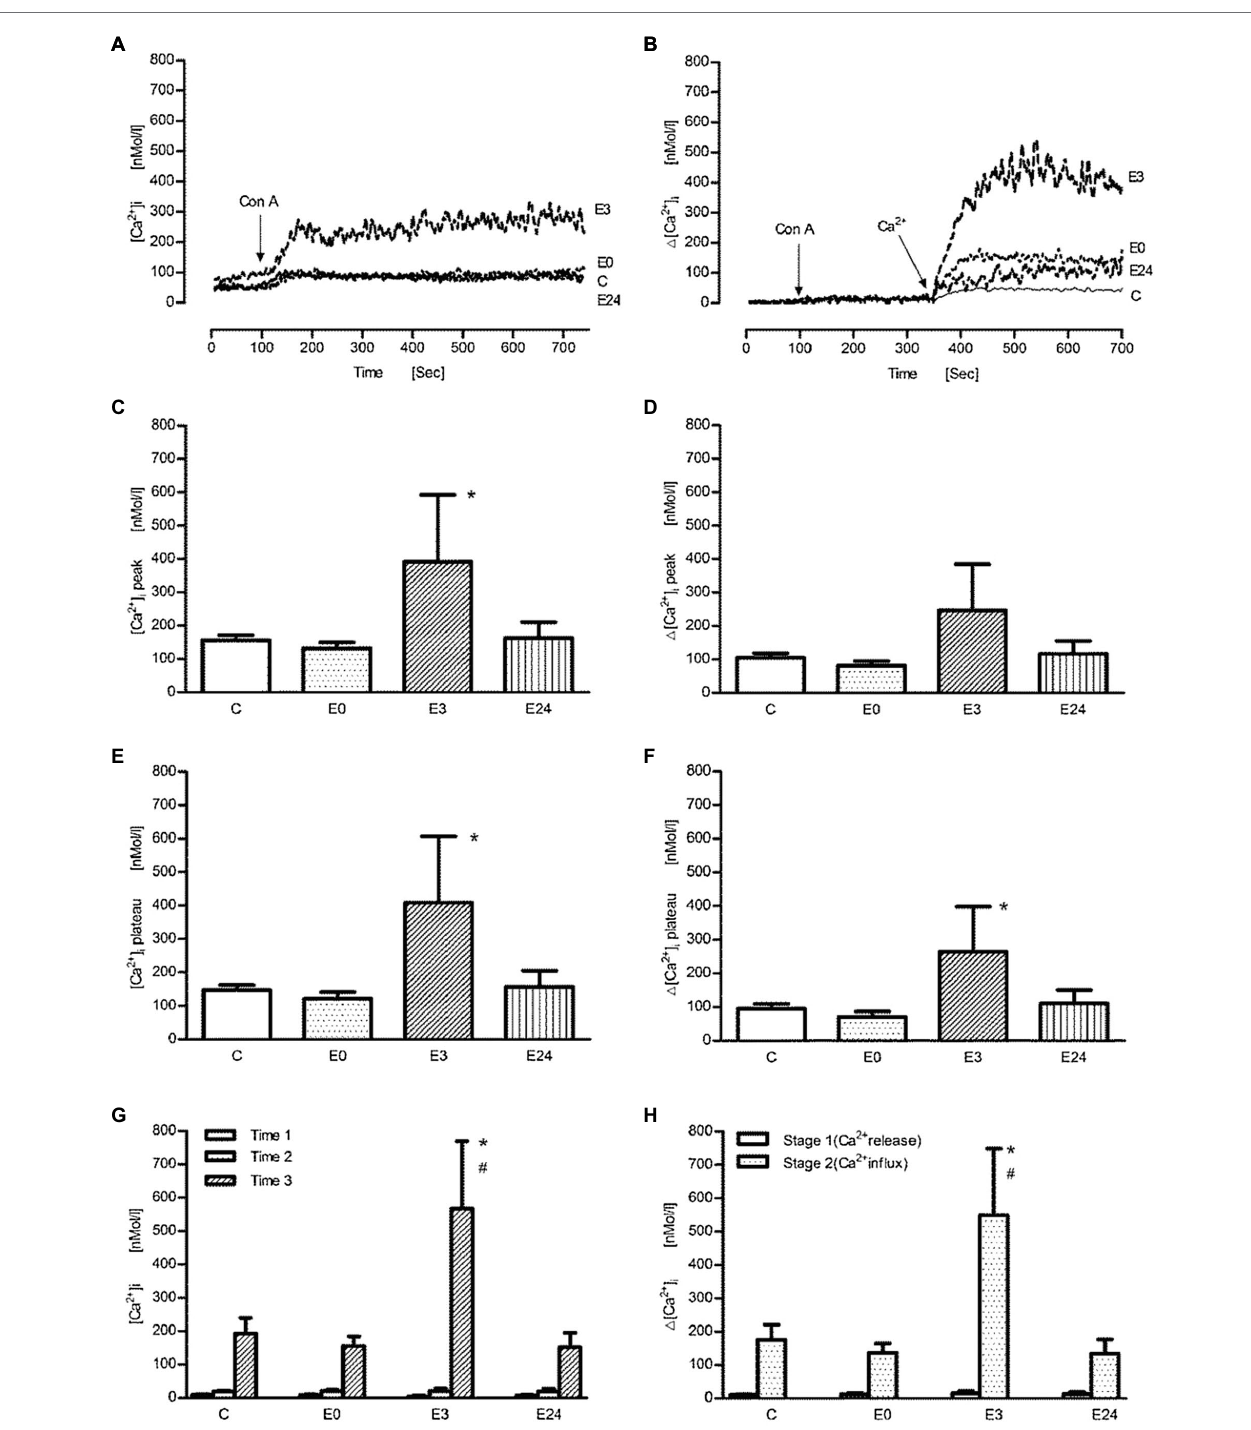
FIGURE 2 | The effect of acute exercise on Con A-induced change of [Ca 2+ ] of murine splenic lymphocytes at the different time points after exercise. (A,B) The representative tracings of Con A-induced change of intracellular Ca 2+ signal in the calcium buffer and the Ca 2+ -free buffer, respectively; arrow shows when Con A (at 100 s) or Ca 2+ (at 350 s) were applied; tracing C, the control group; tracings E0, E3, and E24 indicate the exercise groups with cell isolation at time points after, 3 h, and 24 h after exercise. (C–H) Bar chart diagrams summarizing the results of the entire groups. (C–F) The experiments were performed in the Ca 2+ buffer; [Ca 2+ ] i and Δ [Ca 2+ ] i were referred to as absolute [Ca 2+ ] i and net [Ca 2+ ] i after the addition of Con A, respectively, and were presented separately for peak and plateau phase. (G,H) The measurements were performed in Ca 2+ -free buffer; Time 1: initial resting period, Time 2: addition of Con A, and Time 3: addition of CaCl 2 ; the calculated Δ [Ca 2+ ] i levels of stage 1 and stage 2 indicate Ca 2+ release from ER and transmembrane Ca 2+ influx from extracellular space, respectively. Data are presented as means ± SEM ( n = 5). * means p < 0.05 vs. control; # means p < 0.05 vs.